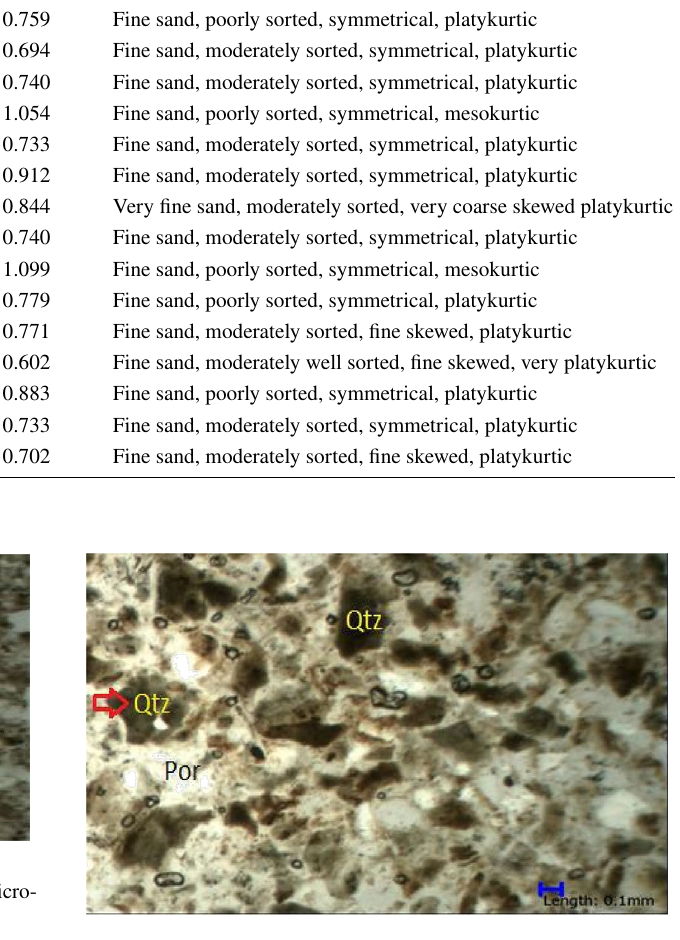
Fig. 8 Quartz grain in Araromi-Obu/Ago-Alaye at depth 57–60 m under crossed polarised light (i.e. nicol). Qtz quartz, Por pore space